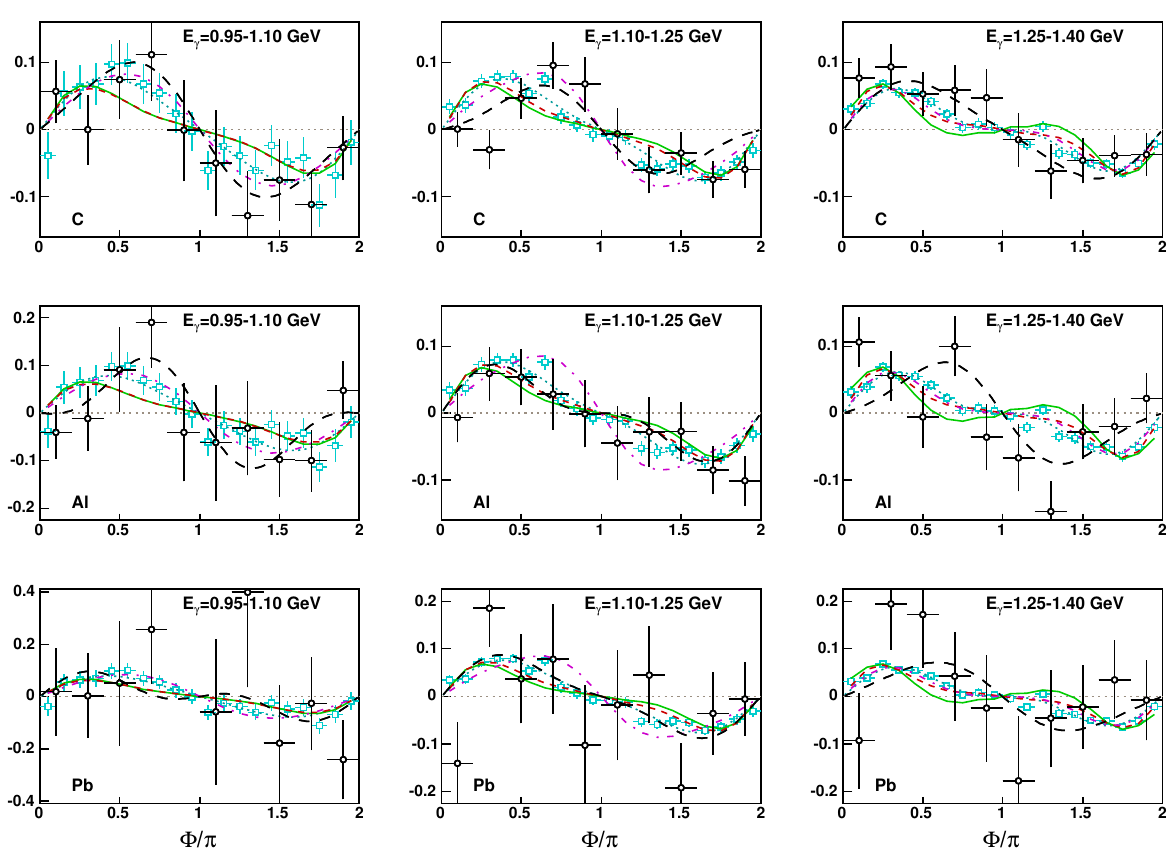
Figure 7. Beam-helicity asymmetry I (cid:12) for the carbon, aluminum, and lead targets (open circles) and the free proton data (cyan open squares) [37]. Curves: Previous version of the Mainz model [25] (magenta dash-dotted line), latest version of the Mainz model from Ref. [37] for a free proton (red dashed line) and for the carbon, aluminum, or lead targets (solid green line). Fits to the experimental data points are performed according to function from Eq. (2) for the nuclear targets (long-dashed black line) and for the hydrogen target (cyan dotted line). The results for carbon, aluminum, and lead are shown in top, middle, and bottom rows, respectively. The data point in the bin 0 . 8 < Φ /π < 1 . 0 and 0 . 95 < E γ < 1 . 10 GeV for Pb is at I (cid:12) = − 0 . 65 ± 0 . 30. Figure taken from Ref.